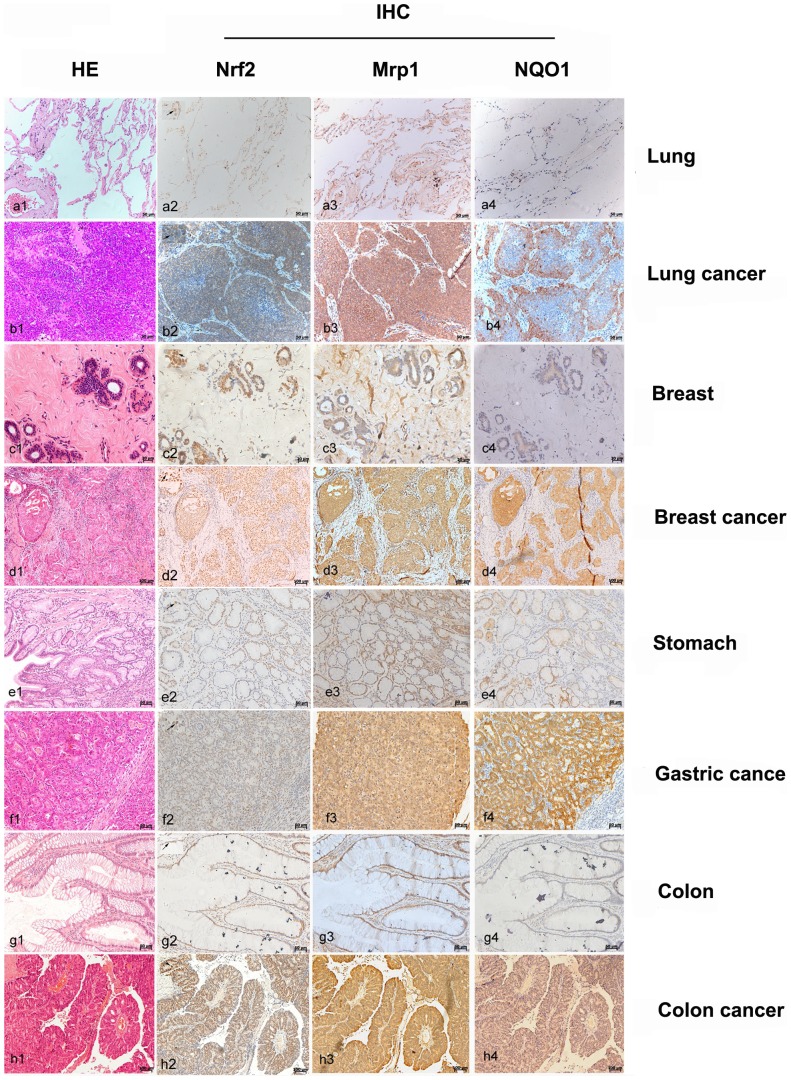
Immunohistochemical staining results for Nrf2, NQO1 and Mrp1 expression in cancer tissuess.The unstained tissue slides from small cell lung cancer, gastric cancer, breast cancer and colon cancer were subject to HE staining (a1 to h1) and IHC staining with antibodies against Nrf2 (a2 to h2), Mrp1 (a3 to h3) and NQO1 (a4 to h4). The bar scales were labeled at the lower right corner of each pictures.